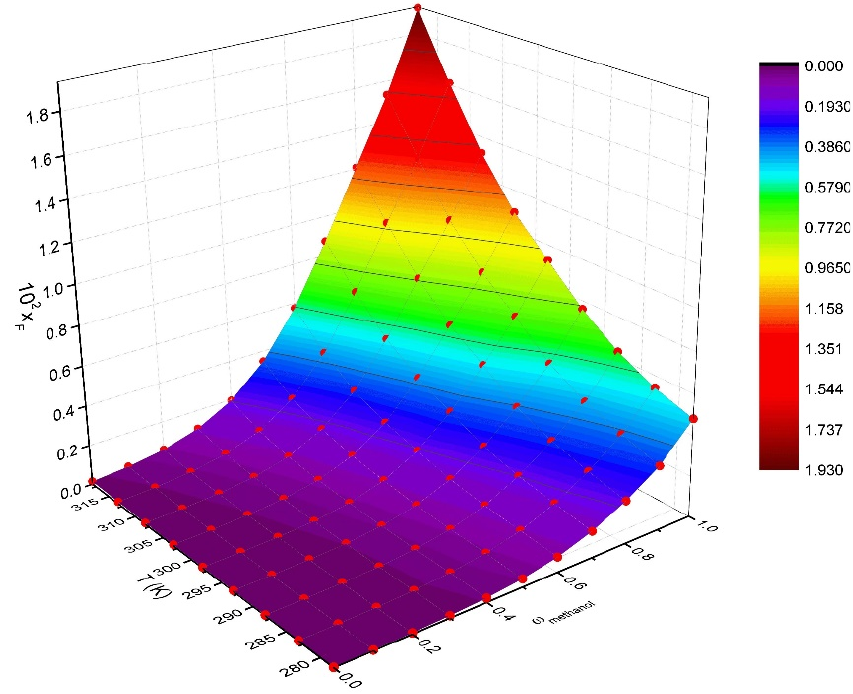
Figure 4. Molar ratio solubility data of florfenicol in methanol + water binary solvents at T = 278.15 K to 318.15 K.